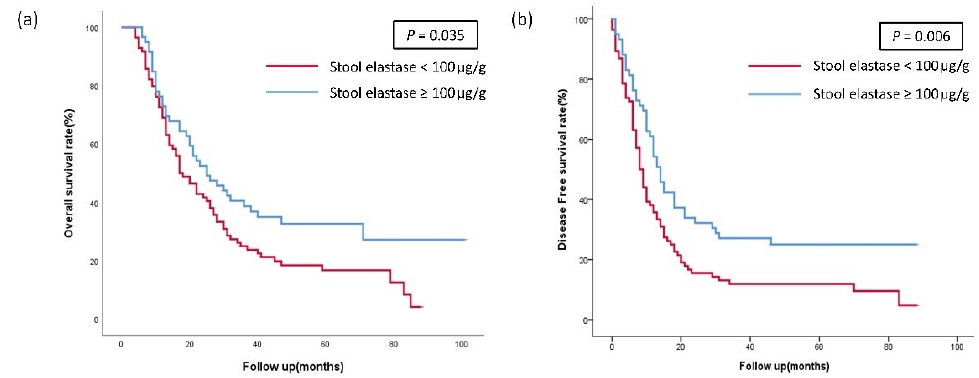
Figure 2. ( a ) The overall survival (OS) and ( b ) disease-free survival (DFS) of the patients according to the stool elastase group.